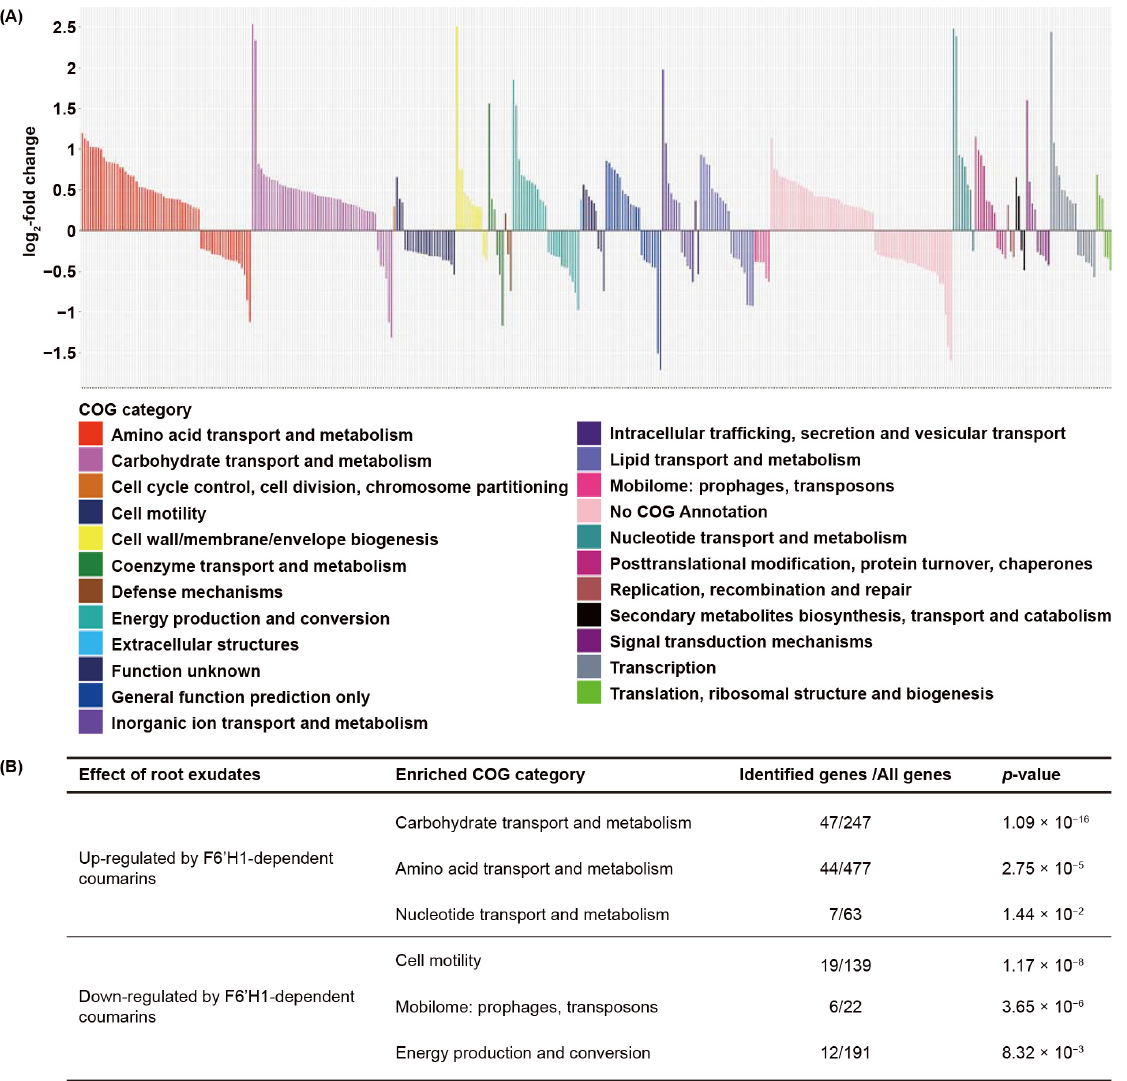
Figure 2. Clusters of orthologous groups (COG) category analysis of differentially expressed genes of WCS417 in response to root exudates from coumarin-producing Col-0 and non-producing f6 ′ h1 plants. ( A ) Expression levels of selected differentially expressed genes in response to root exudates derived from Col-0 and f6 ′ h1 under iron deficiency. Up/down-regulated DEGs are WCS417 genes with a significantly higher/lower level of expression (FDR <0.05) in response to root exudates from Col-0, in comparison to the response to root exudates from f6 ′ h1 . DEGs with a valid annotation of clusters of orthologous groups were selected. In log2-fold change, positive values mean that the genes are up-regulated and negative values mean that the genes are down-regulated by F6 ′ H1- dependent coumarins in the root exudates. Different colors of the bars correspond to different COG categories. ( B ) COG enrichment analysis of selected DEGs in response to root exudates de- rived from iron-starved Col-0 and f6 ′ h1 plants. Overrepresented COG categories ( p -value < 0.05) were identified in both up- and down-regulated DEGs by F6 ′ H1-dependent coumarins. Listed are the number of identified genes in the set of DEGs relative to all genes in the WCS417 genome that are assigned to each COG category .